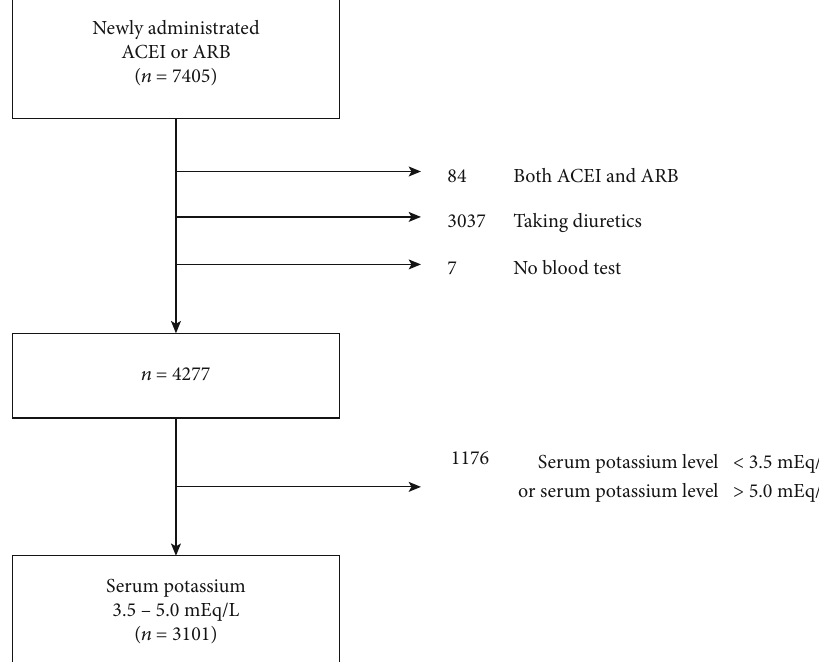
Figure 1: Selection of hospital inpatients who were starting angiotensin-converting enzyme inhibitor or angiotensin receptor blocker